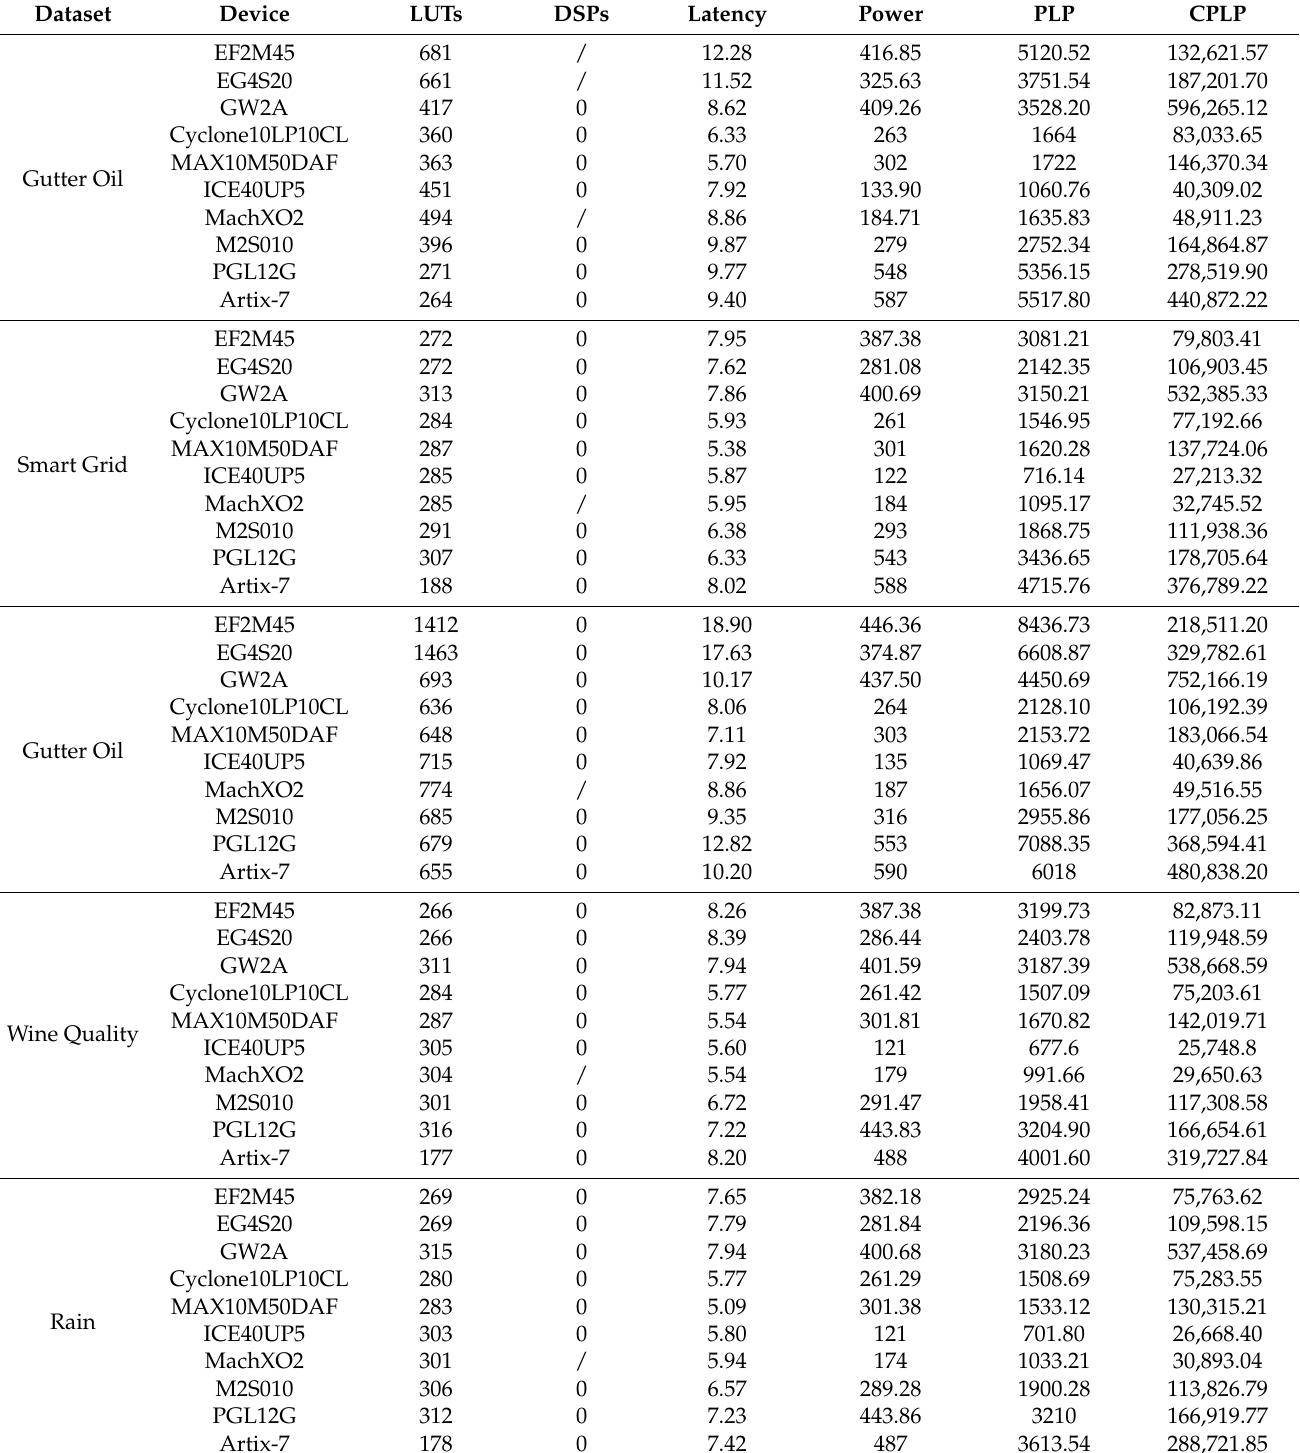
Table A4. DT deployment results on the low-cost